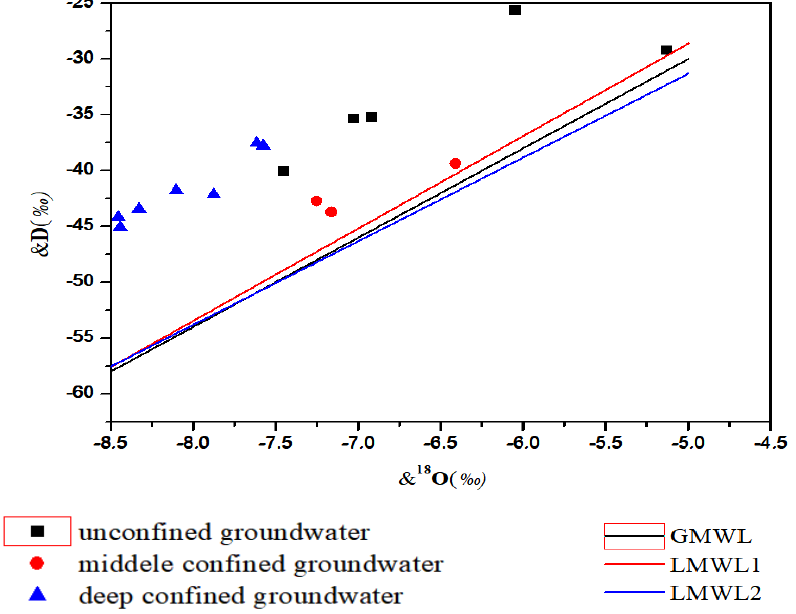
Figure 1. Location of the sampling sites.